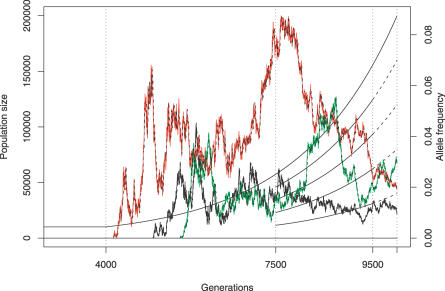
Illustration of the Evolutionary ScenarioIllustration of the evolutionary scenario of a simulation with three DSL. Demographic model (left axis): The population starts at size 10,000 and begins to grow exponentially at generation 4,000. The population is split into five equal-sized subpopulations at generation 7,500 (with subpopulations separated with solid lines) and reaches size 2 × 105 at generation 10,000. Migration is allowed from generation 9,500 to 10,000 (with subpopulations separated by dashed lines). Disease allele frequencies (right axis): The DSL are under advantageous selection pressure, with fitnesses of 1, 1.0001, and 1.0002 for genotypes AA, Aa, and aa, respectively, where a is the disease susceptibility allele. The present disease allele frequencies are 0.01, 0.02, and 0.03, respectively. The trajectories simulated backward in time are plotted in solid lines with different colors. The trajectories obtained during forward-time controlled random mating are plotted as dotted lines, which are indistinguishable from the simulated trajectories.